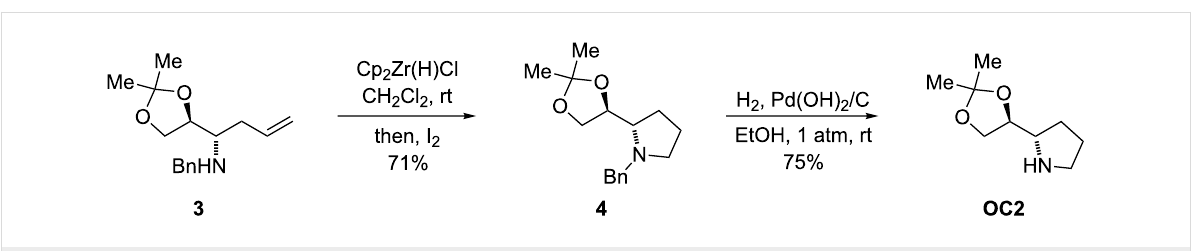
Scheme 2: Synthesis of new organocatalyst OC2 .